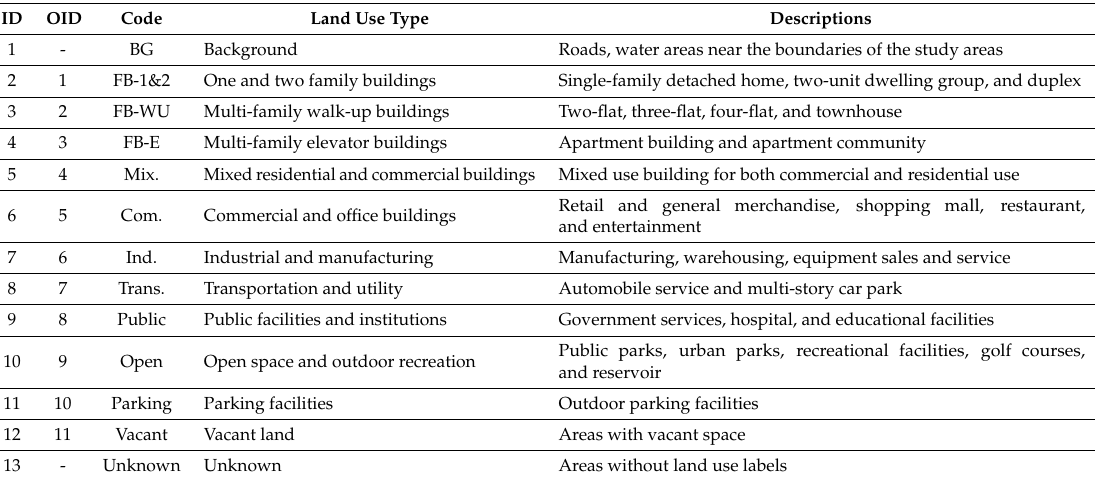
Table 1. Adjusted land use categories of New York